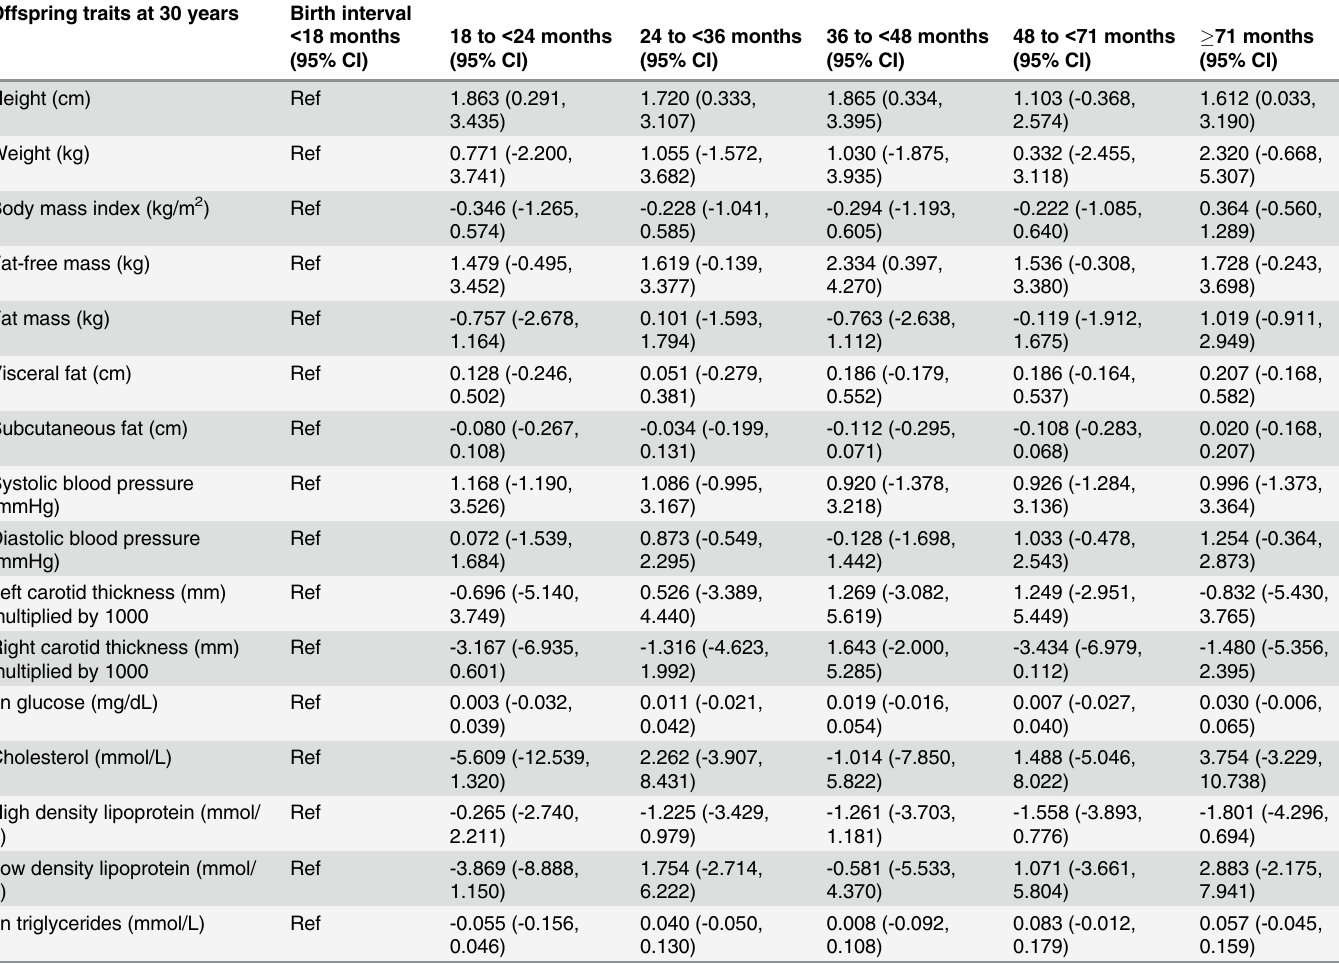
Table 3. Multivariable regression results with birth interval as a categorical